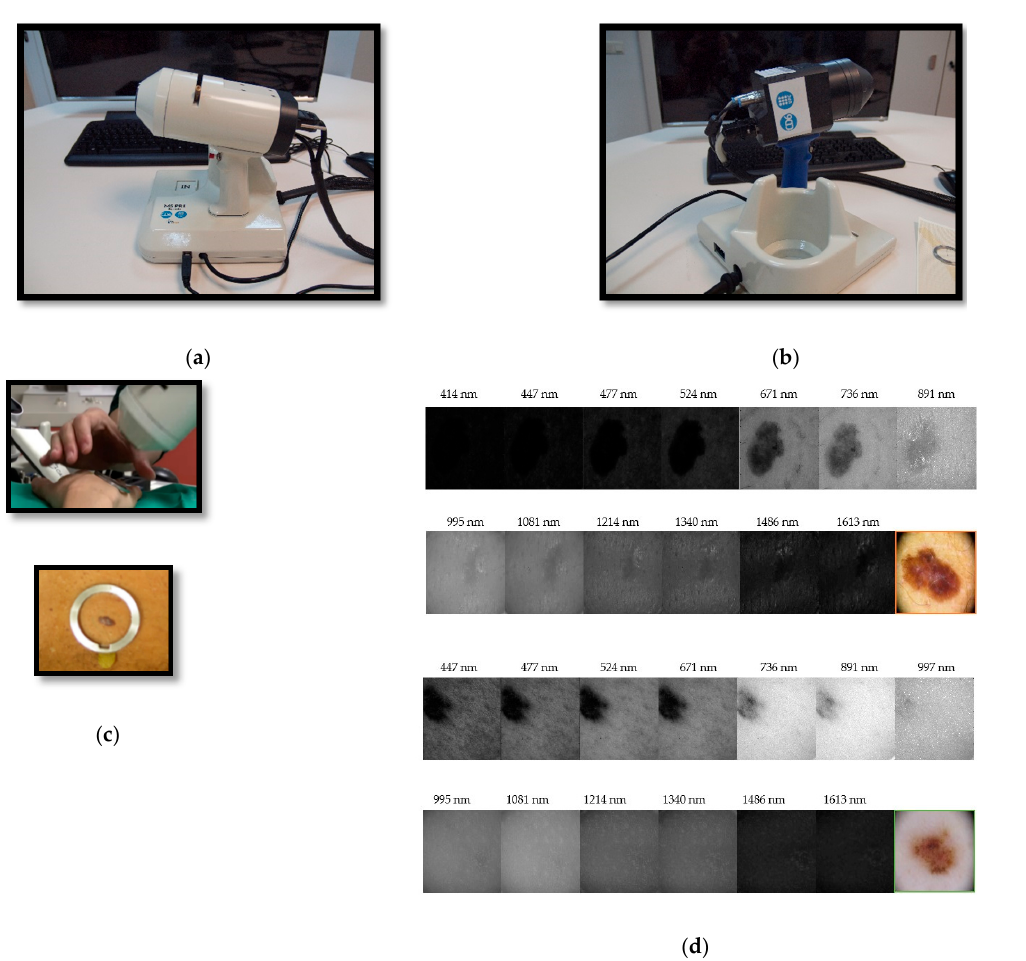
Figure 2. From authors Rey-Barroso et al. [43], multispectral (MS) imaging devices ( a ) General view of the previously developed handheld visible to the near-infrared (VIS-NIR) MS device. ( b ) General view of the handheld extended near- infrared (exNIR) MS device. ( c ) Clinical measurement and metallic ring, which is glued to the patient’s skin for the tip of both systems to place them in the same position and parallel to the skin, without making any contact. ( d ) MS images of a melanoma (top) and a nevi (bottom). The structure of the melanoma is still visible at the longest wavelengths. Additionally, Godoy et al. [26] used a longwave infrared (LWIR) camera to make dynamic thermal imaging (DTI) of skin lesions. The LWIR camera uses a focal-plane array of quantum-well infrared photodetectors. The thermal infrared image sequences acquired allowed the discrimination among benign and malignant skin conditions. Fioravanti et al. [37] employed a sensor that did not make imaging per se, but rec- orded the IR spectrum from 3330 to 3570 nm of skin biopsies. Table 2. Contributions of MS imaging to skin cancer diagnosis. Study